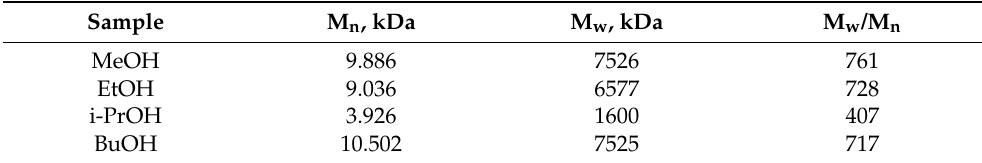
Table 5. Molecular weights of adhesive